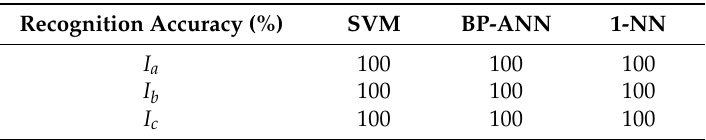
Table 10. Results of recognition accuracy in training and test between SLGF on the line 2 and motor starting current on the load 2 with the